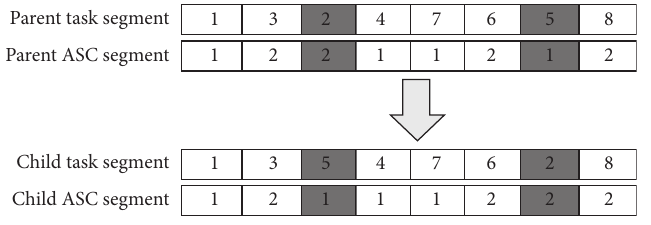
Figure 8: Chromosome mutation operation.